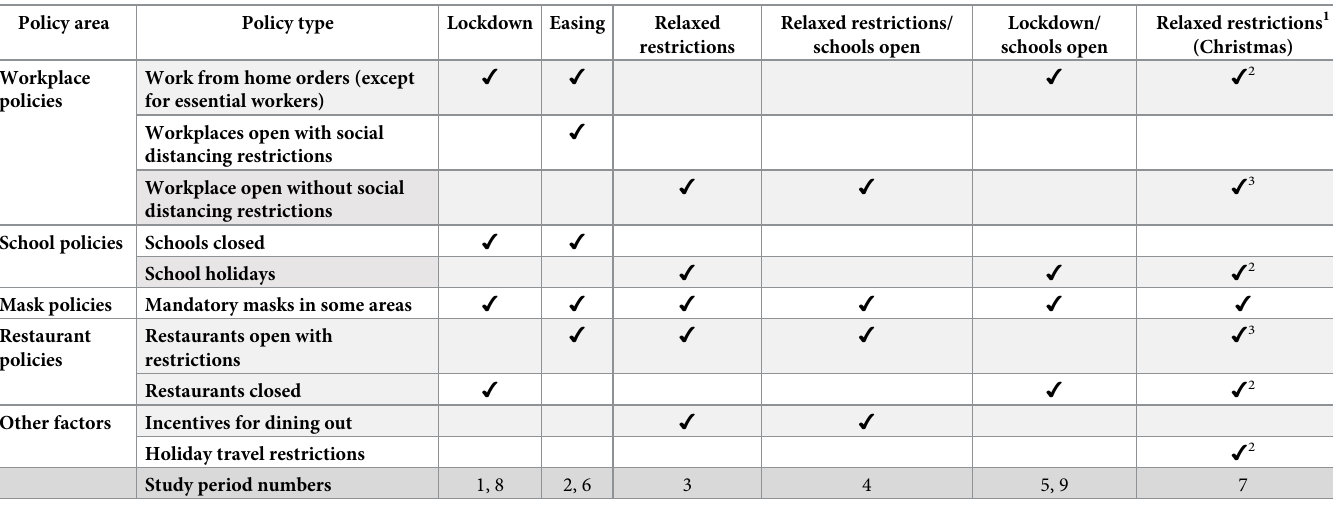
Table 2. Policy interventions in England for study